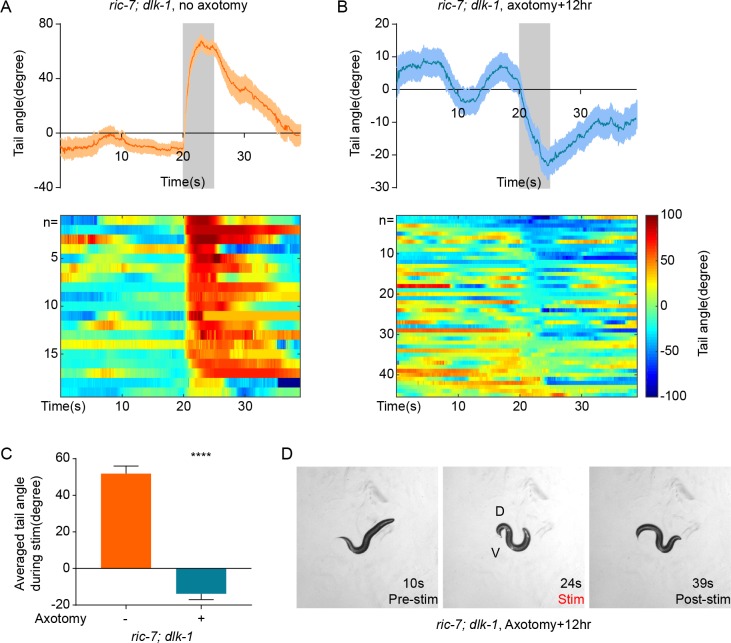
Behavior response of ric-7(n2657); dlk-1(ju476) animals with and without axotomy.(A) ric-7(n2657); dlk-1(ju476) intact animals show robust dorsal tail bending. The shaded area represents the 5 s stimulation. Mean ± SEM. (B) ric-7(n2657); dlk-1(ju476) axotomized animals show robust ventral tail bending 12 hr after axotomy. Mean ± SEM. (C) Averaged tail angle during stimulation of animals in (A) and (B). Mean and SEM. ****p<0.0001. Unpaired t test. (D) Images from a movie showing the ventral-bending behavior of a ric-7(n2657); dlk-1(ju476) animal 12 hr after axotomy.